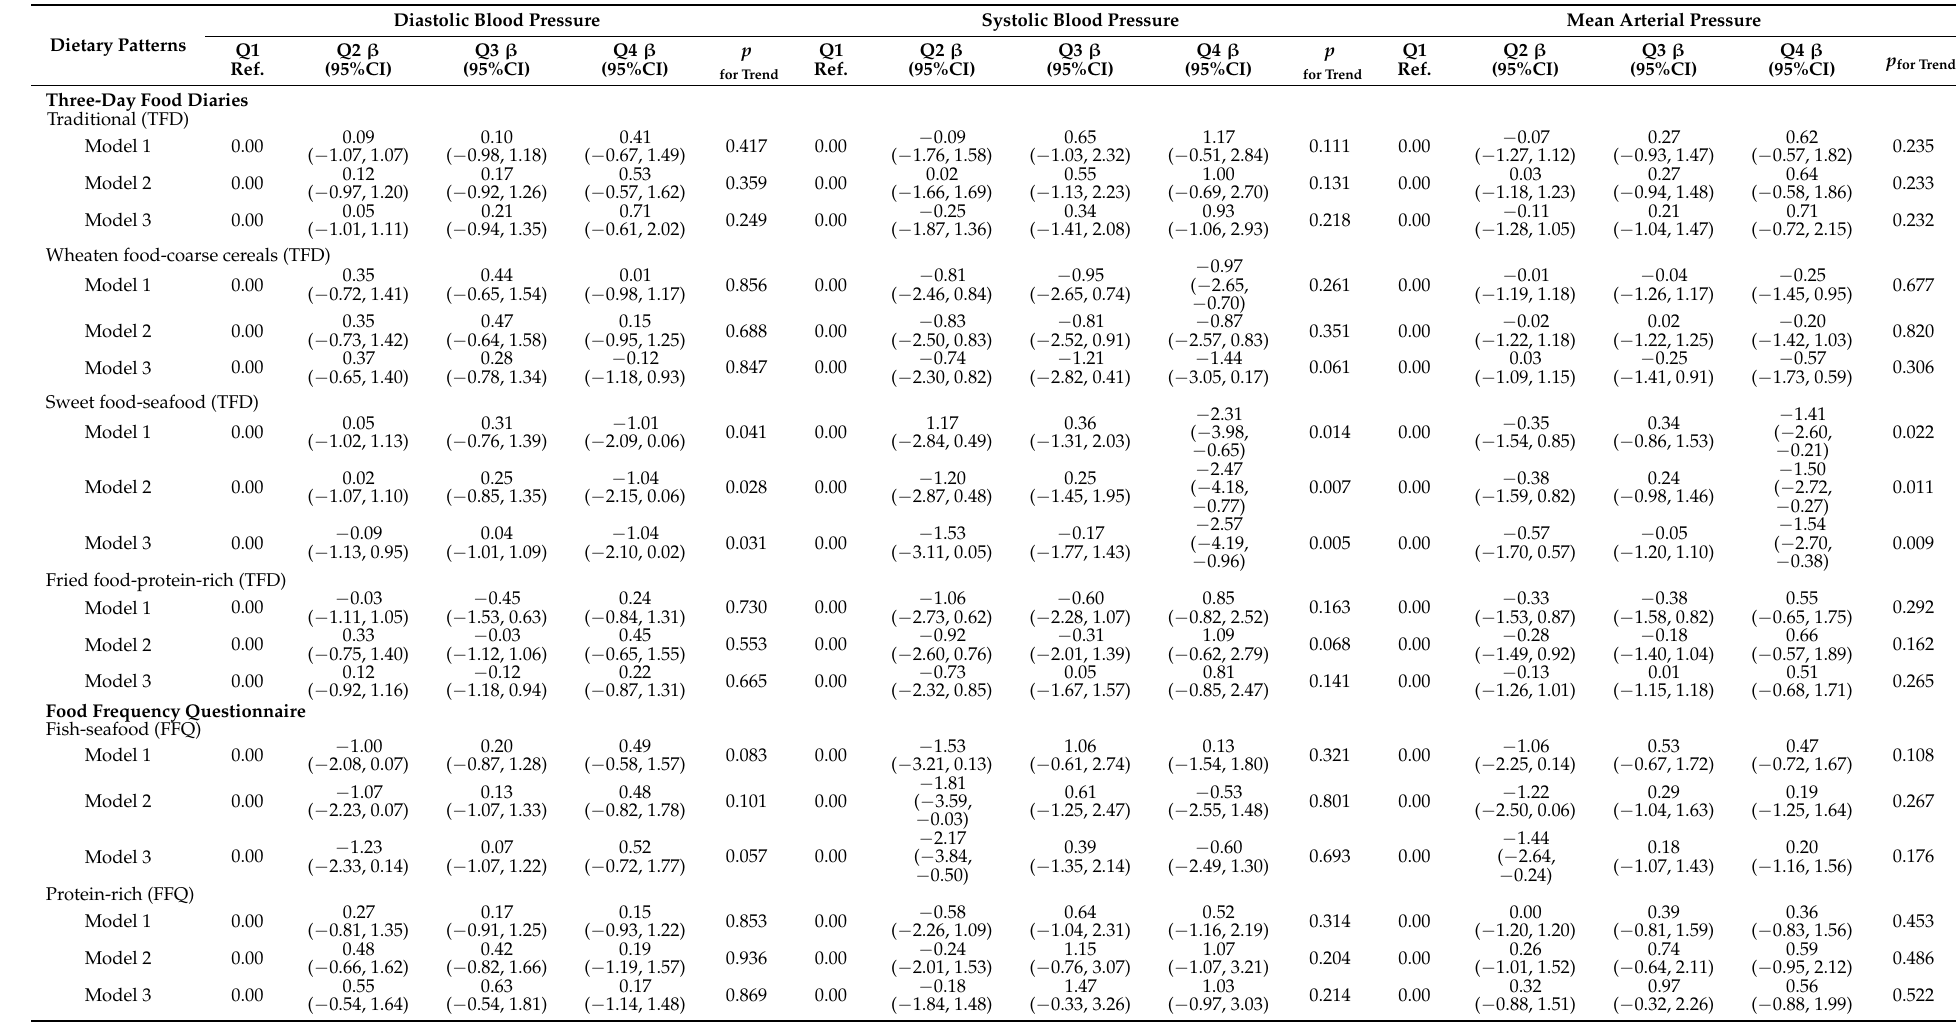
Table 3. Associations of maternal dietary pattern scores during pregnancy, in quartiles, with mean blood pressure throughout pregnancy. Dietary